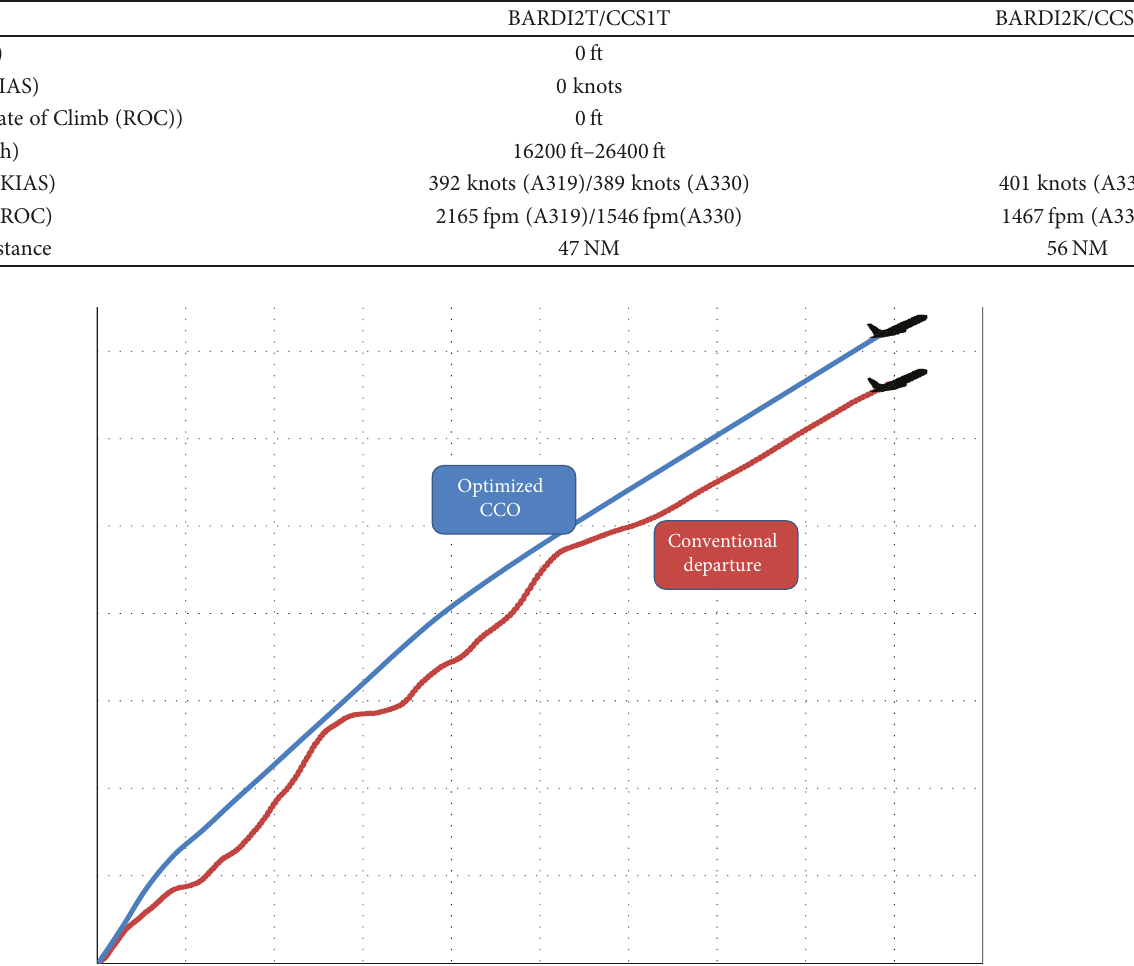
Table 2: Boundary conditions.